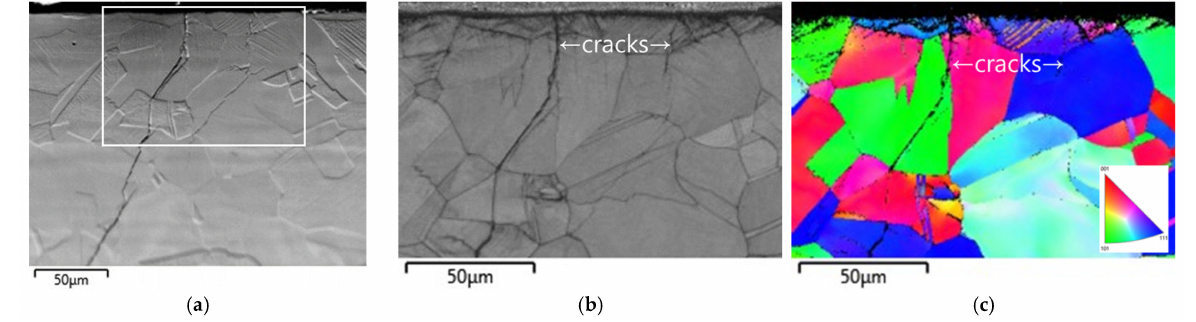
Figure 16. EBSD results of the cracking area of non-peened 304L base metal after SCC test: ( a ) SEM image, ( b ) band contrast, ( c ) inverse pole figure (IPF) coloring.